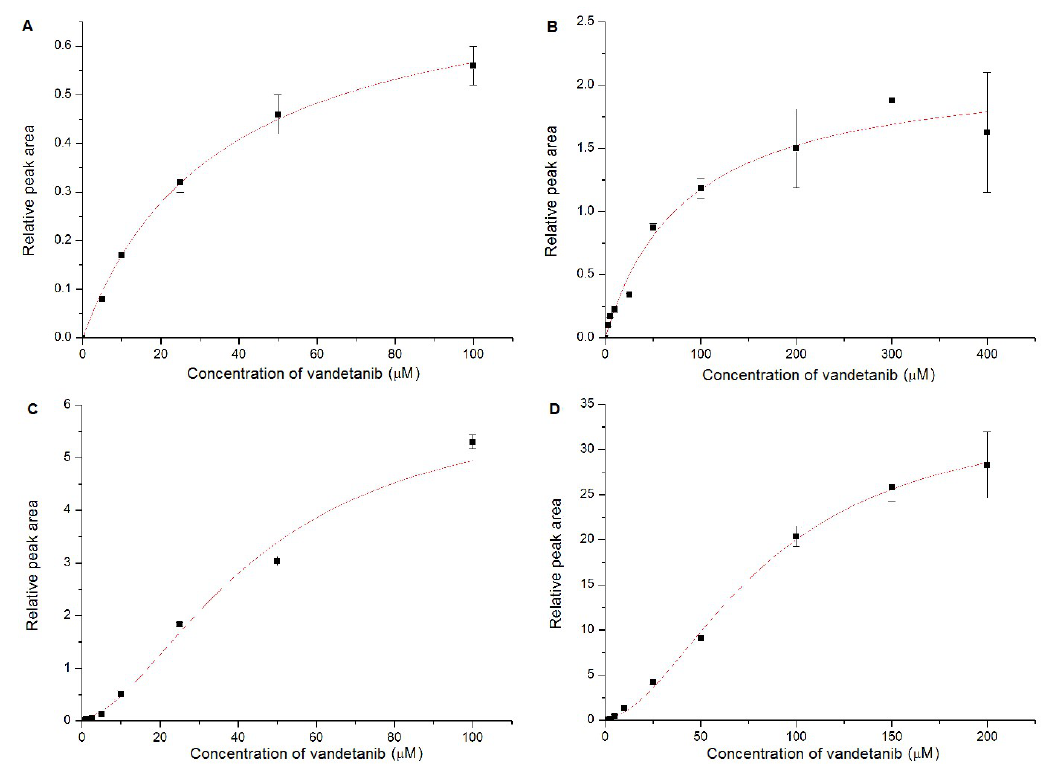
Figure 8. Enzyme kinetics of vandetanib oxidation to N -desmethylvandetanib catalyzed by CYP1A1 ( A ), 2D6 ( B ), 3A4 ( C ) and this enzyme in the presence of cytochrome b 5 ( D ). Values represent means ± SD of three independent in vitro incubations ( n = 3).